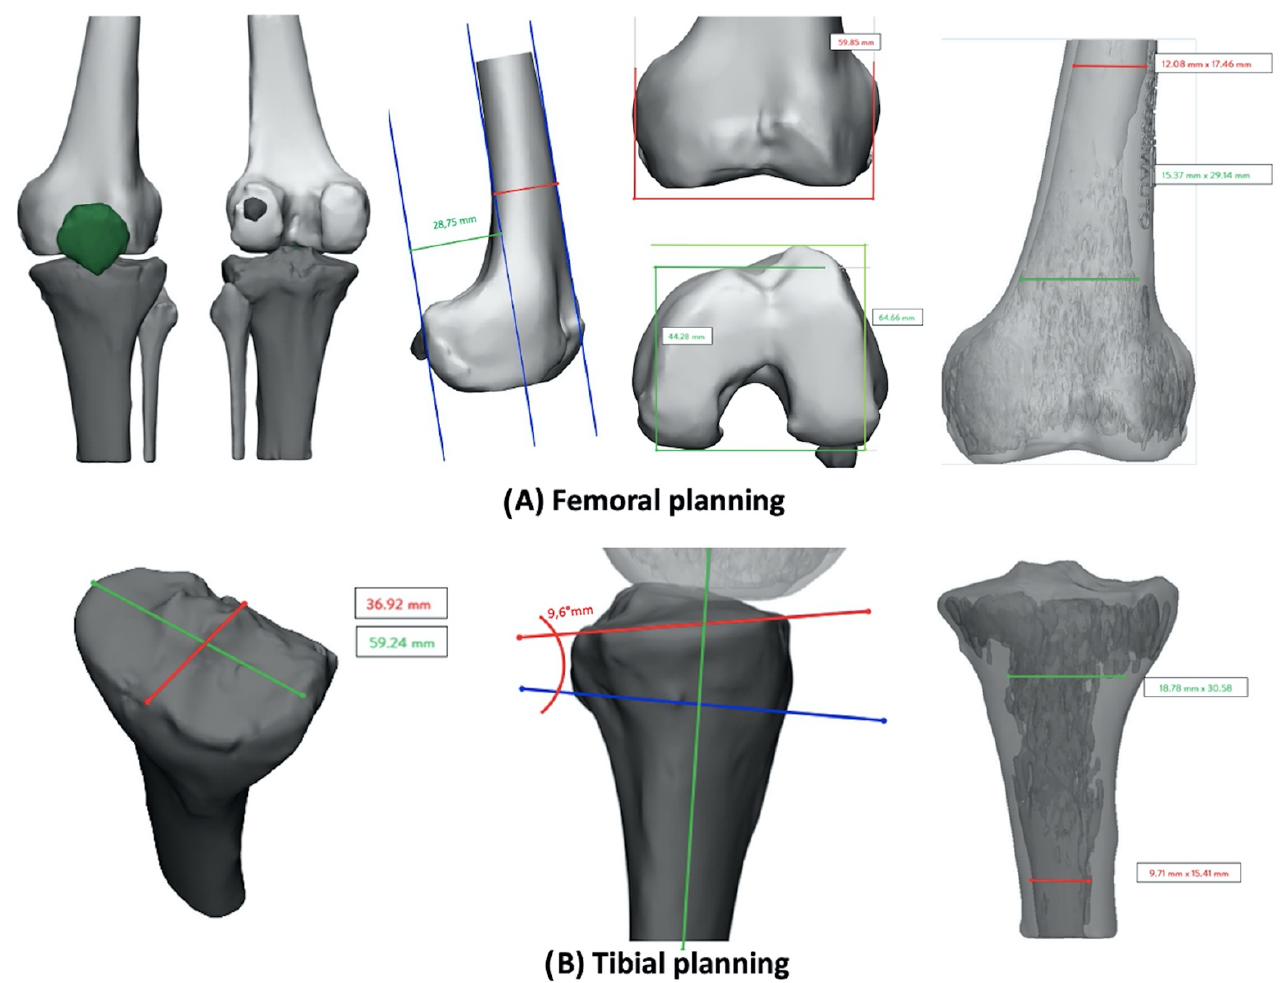
Figure 2. Pre-operative planning based on 3D-printed model: ( A ) femoral measurements; ( B ) tibial measurements.